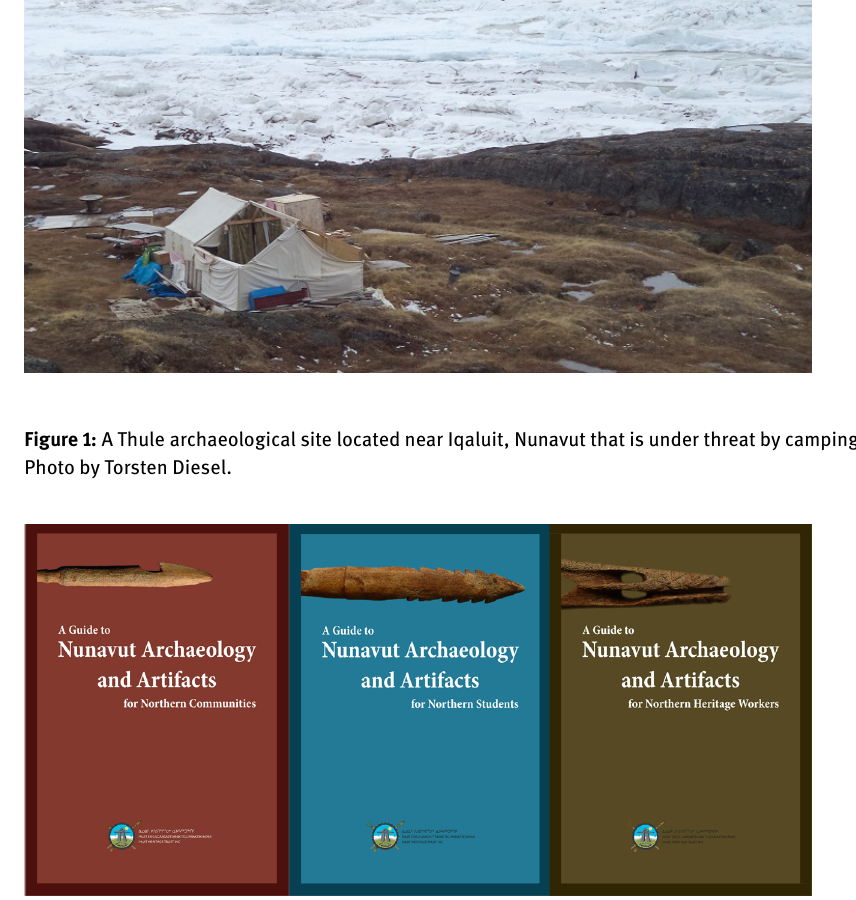
Figure 2: The three volumes comprising the IHT guidebook